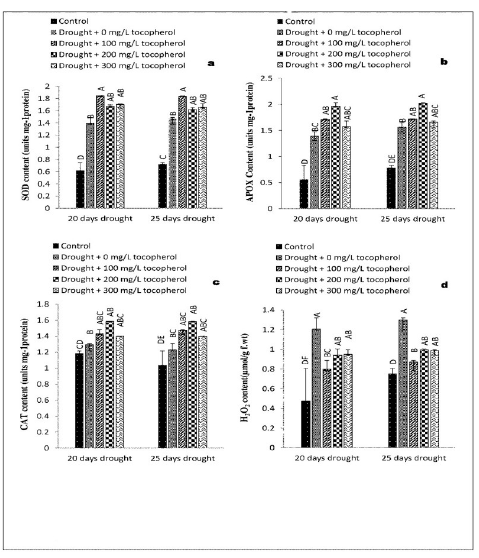
Fig 6. Effect of varying levels of exogenously applied α -tocopherol on superoxide dismutase content ( a ) ascorbate peroxidase content ( b ) catalase content ( c ) hydrogen peroxide content ( d) of lentil ( Lens culinaris Medik.) grown under varying drought stress condition (Mean ± standard error.) letters (A–E) indicating least significance difference among the mean values at p � 0.05.